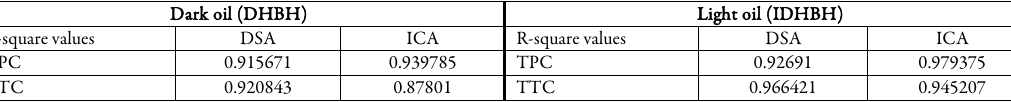
Table 2. Comparison of FT-IR peak values in dark and light oil Light oil Dark oil Peak features Peak